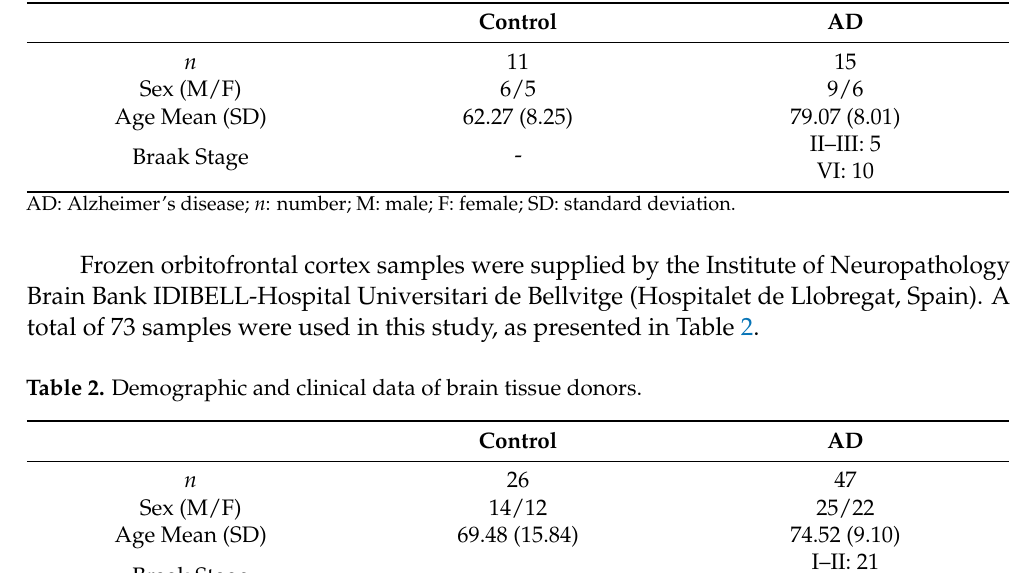
Table 1. Demographic and clinical data of gland tissue donors.